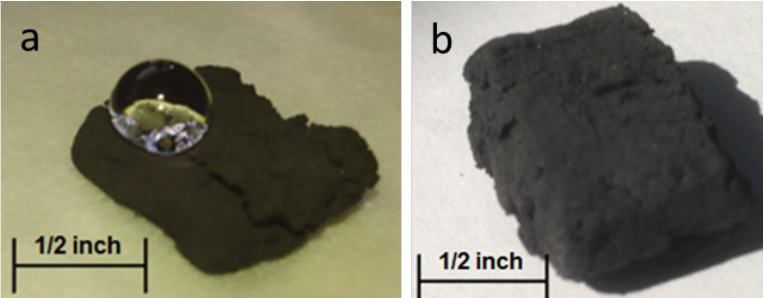
Figure 7. Hydrophobicity. ( a ) Drop of water suspended in the foam surface; ( b ) A drop of oil gets readily absorbed within the foam structure, showing no evidence of oil on the surface after just fractions of a second of